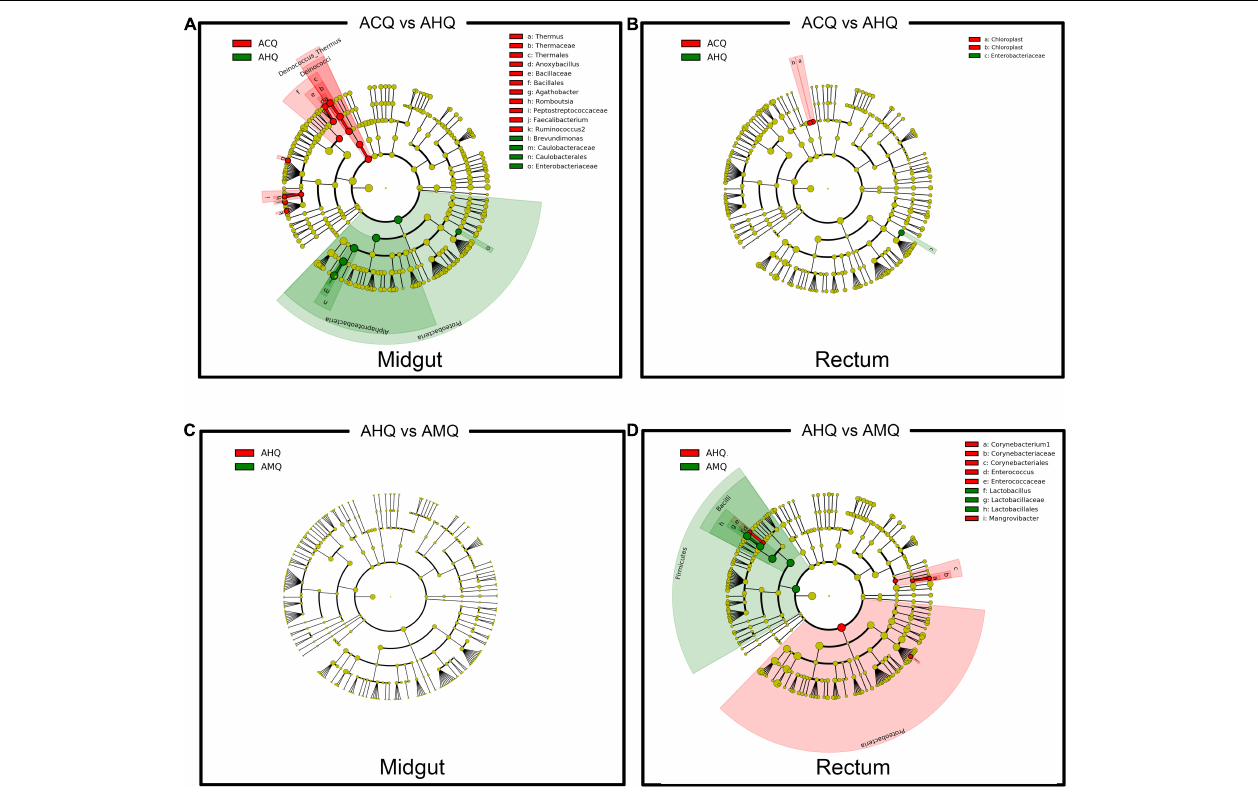
FIGURE 4 | Genetic-specific and environmental-specific taxa filtrating through intergroup comparison. (A,B) The differentially abundant taxa of the midgut and rectum comparing ACQs (red) vs. AHQs (green) were identified using LEfSe analysis and displayed in color to detect the genetic-specific taxa. (C,D) The other comparison between AHQs (red) and AMQs (green) in the midgut and rectum was also performed to identify the environmental-specific taxa. Each circle diameter is proportional to the taxon abundance.